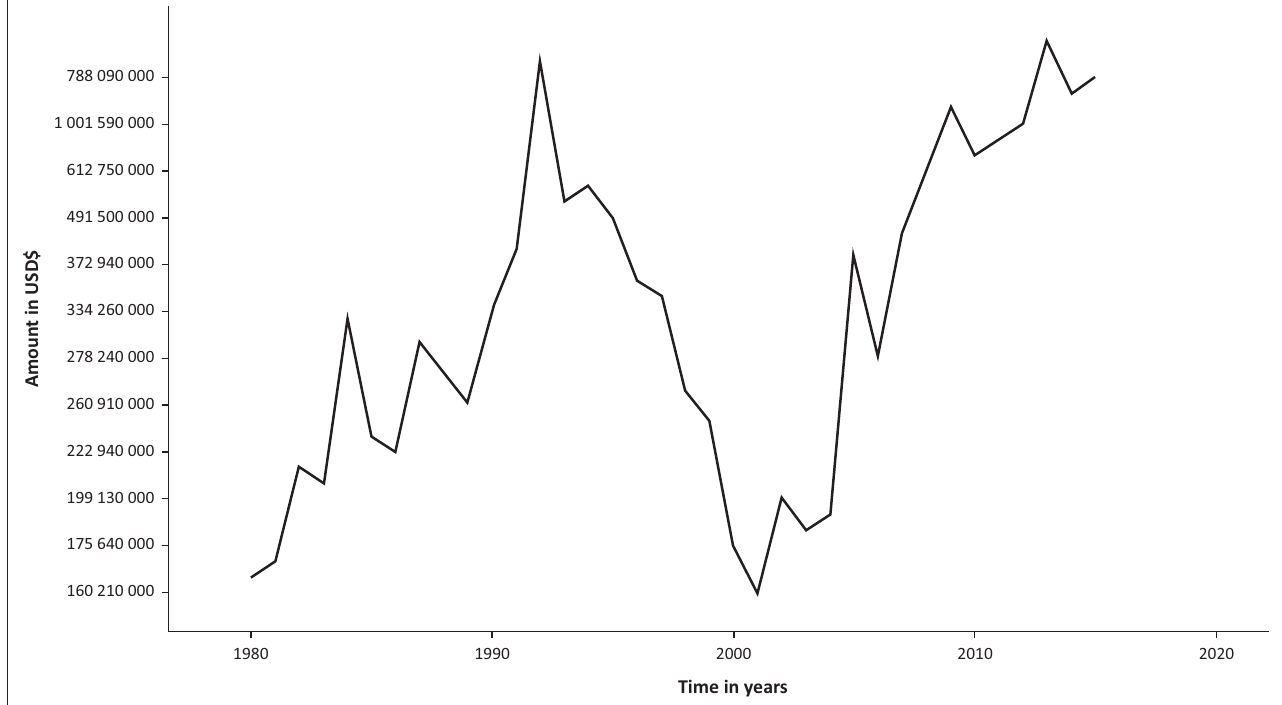
FIGURE 1: Net official development assistance and official aid for Zimbabwe from 1980 to